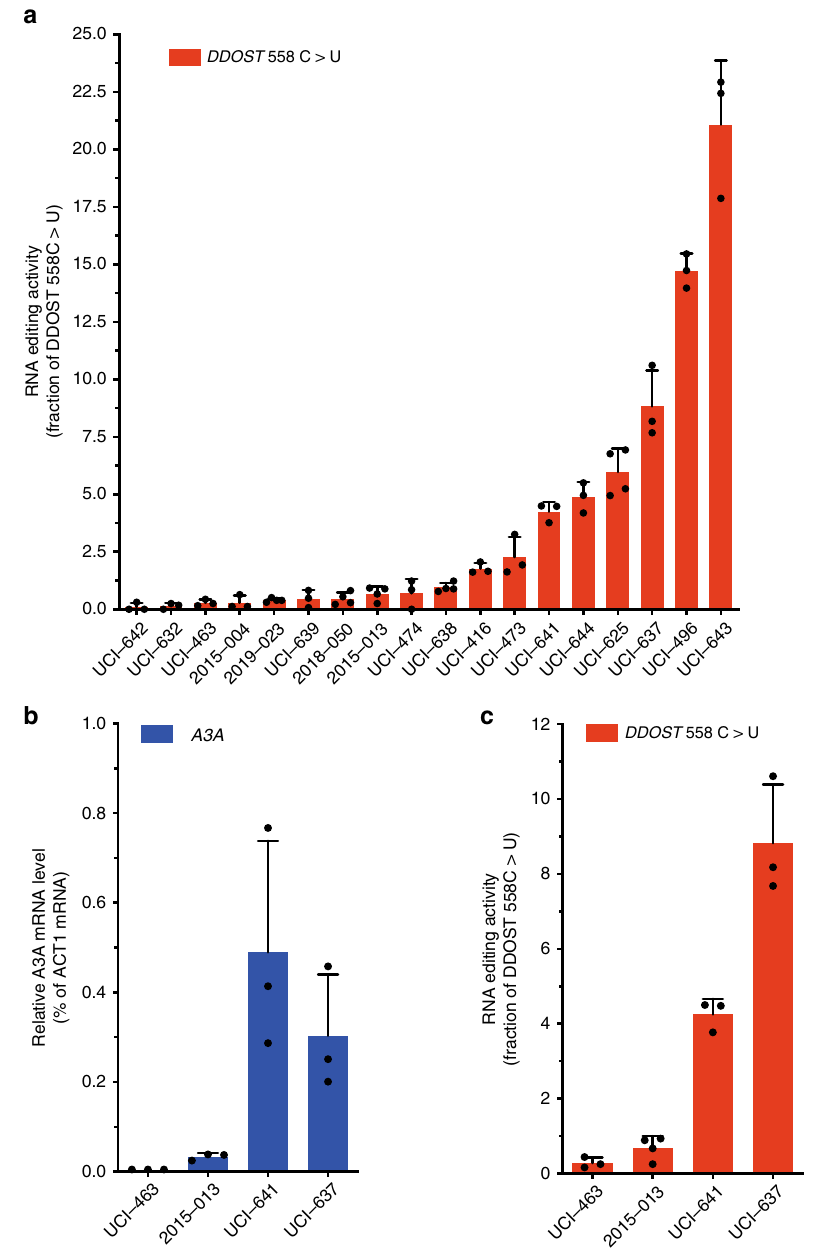
Fig. 7 APOBEC3A activity in a panel blood tumors. a Levels of edited DDOST 558C>U were quanti fi ed using the ddPCR assay in a panel of patient blood tumor samples. For each sample, independent PCR reactions were performed to determine the level of edited DDOST 558C>U . Error bar: S.D. ( n ≥ 3) b , c Levels of A3A mRNA and edited DDOST 558C>U were quanti fi ed by RT-qPCR and ddPCR respectively in the indicated patients ’ blood tumor samples. For each sample, three or more independent PCR reactions were performed to determine the level of A3A mRNA or DDOST 558C>U . Error bar: S.D. Edited DDOST 558C>U level results showed in c were duplicated from the a of the corresponding patient samples. Source data are provided as a Source Data fi